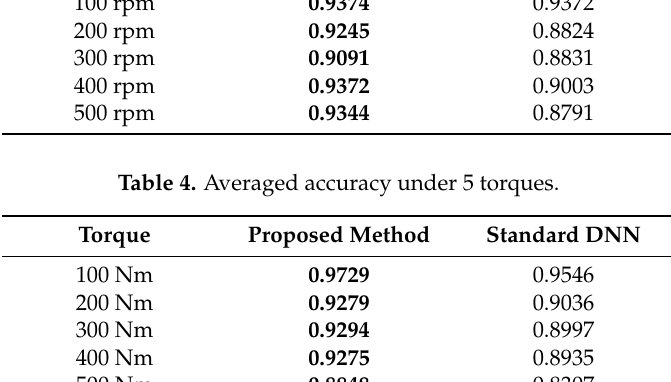
Table 3. Averaged accuracy under 5 speeds. Table 4. Averaged accuracy under 5 torques.